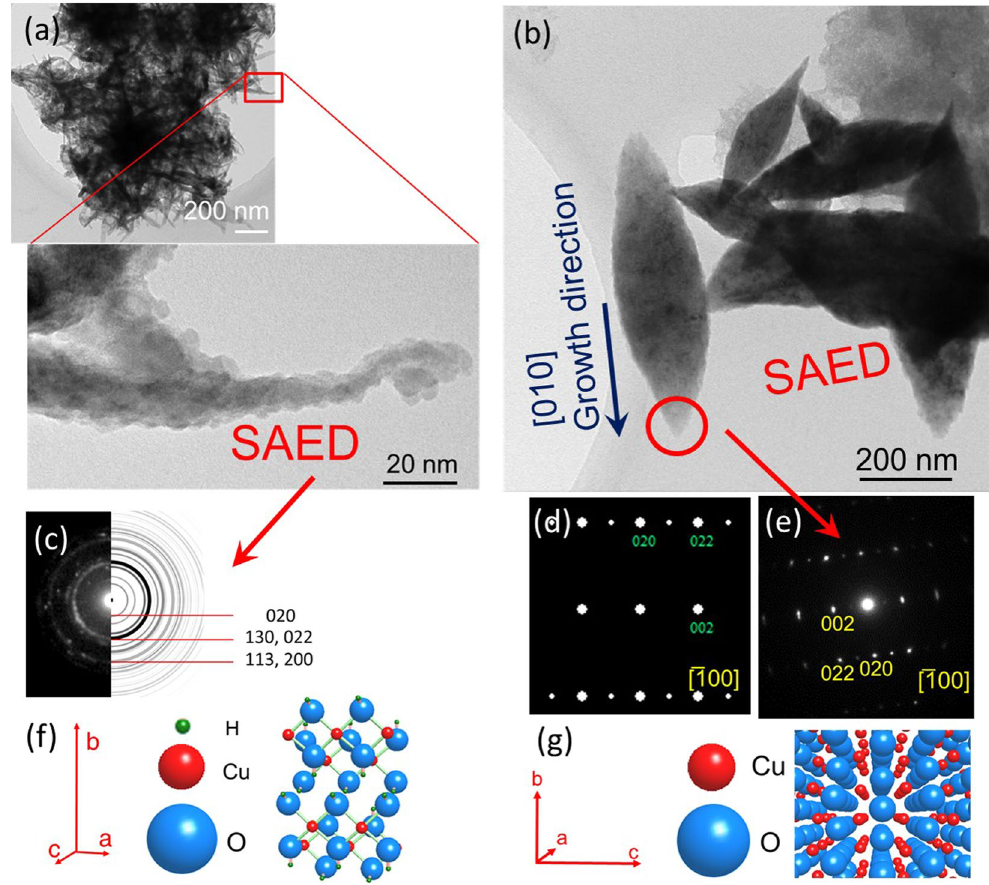
Figure 6. Structural characterisation of CuO crystals. TEM images of ( a ) bundled Cu(OH) 2 particles and ( b ) leaves of CuO nanoflowers. The crystals of the oxide are considered to have peeled off in the growth process during UV irradiation. ( c ) Cu(OH) 2 SAED ring pattern of the portion surrounded by a red square in ( a ) and calculated ring pattern of Cu (OH) 2 on the right side. ( d ) Calculated electron diffraction pattern of CuO and ( e ) SAED pattern of the portion surrounded by a red circle of the CuO leaf in ( b ). ( f ) The crystal structure of Cu(OH) 2 : Orthorhombic pyramidal with lattice parameters of a = 0.295, b = 1.059, c = 0.5527 (nm). ( g ) The crystal structure of CuO: Monoclinic crystal with lattice parameters of a = 0.4684, b = 0.3423, c = 0.5129 (nm), α = 90°, β = 99.54°, γ =